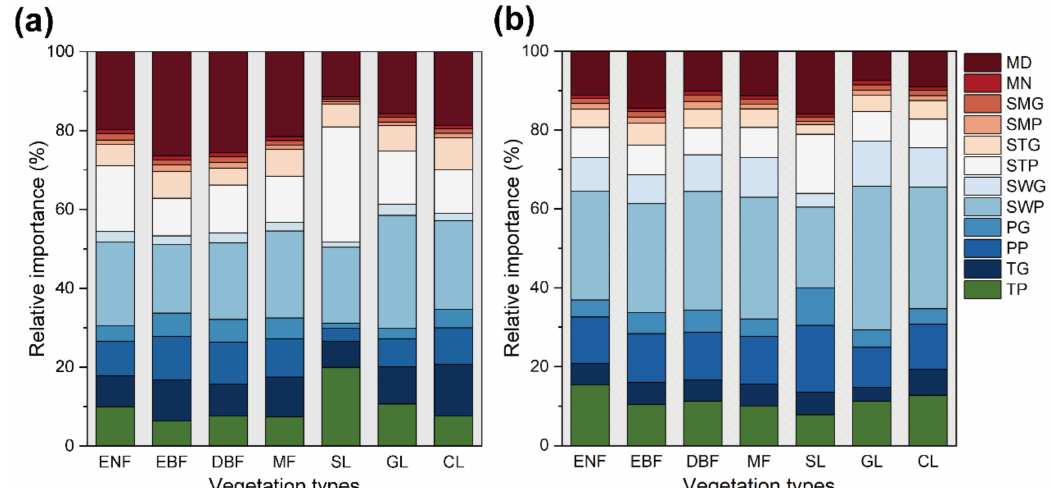
Figure 9. The relative importance of drivers that affect interannual variations in LSP for different vegetation types. Relative importance was derived from the importance scores of variables (VI) based on RF models established for different vegetation types: ( a ) SOS. ( b ) EOS. Different colors indicate different factors. Note: SOS or EOS as response variable in the RF model. The specific values for the relative importance of each driver are in Table